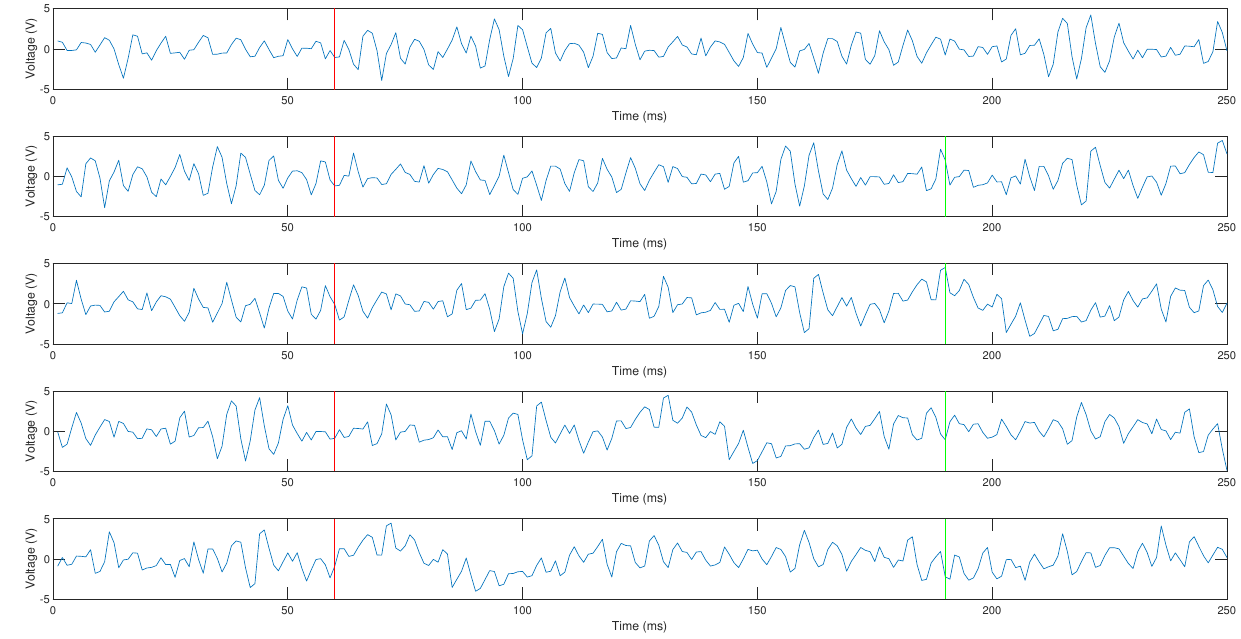
Figure 7. From top to bottom, windows 40, 41, 42, 43, and 44 of the signal of channel 1 of the person 1 of the repetition 1 of the EMG signals of the right leg are